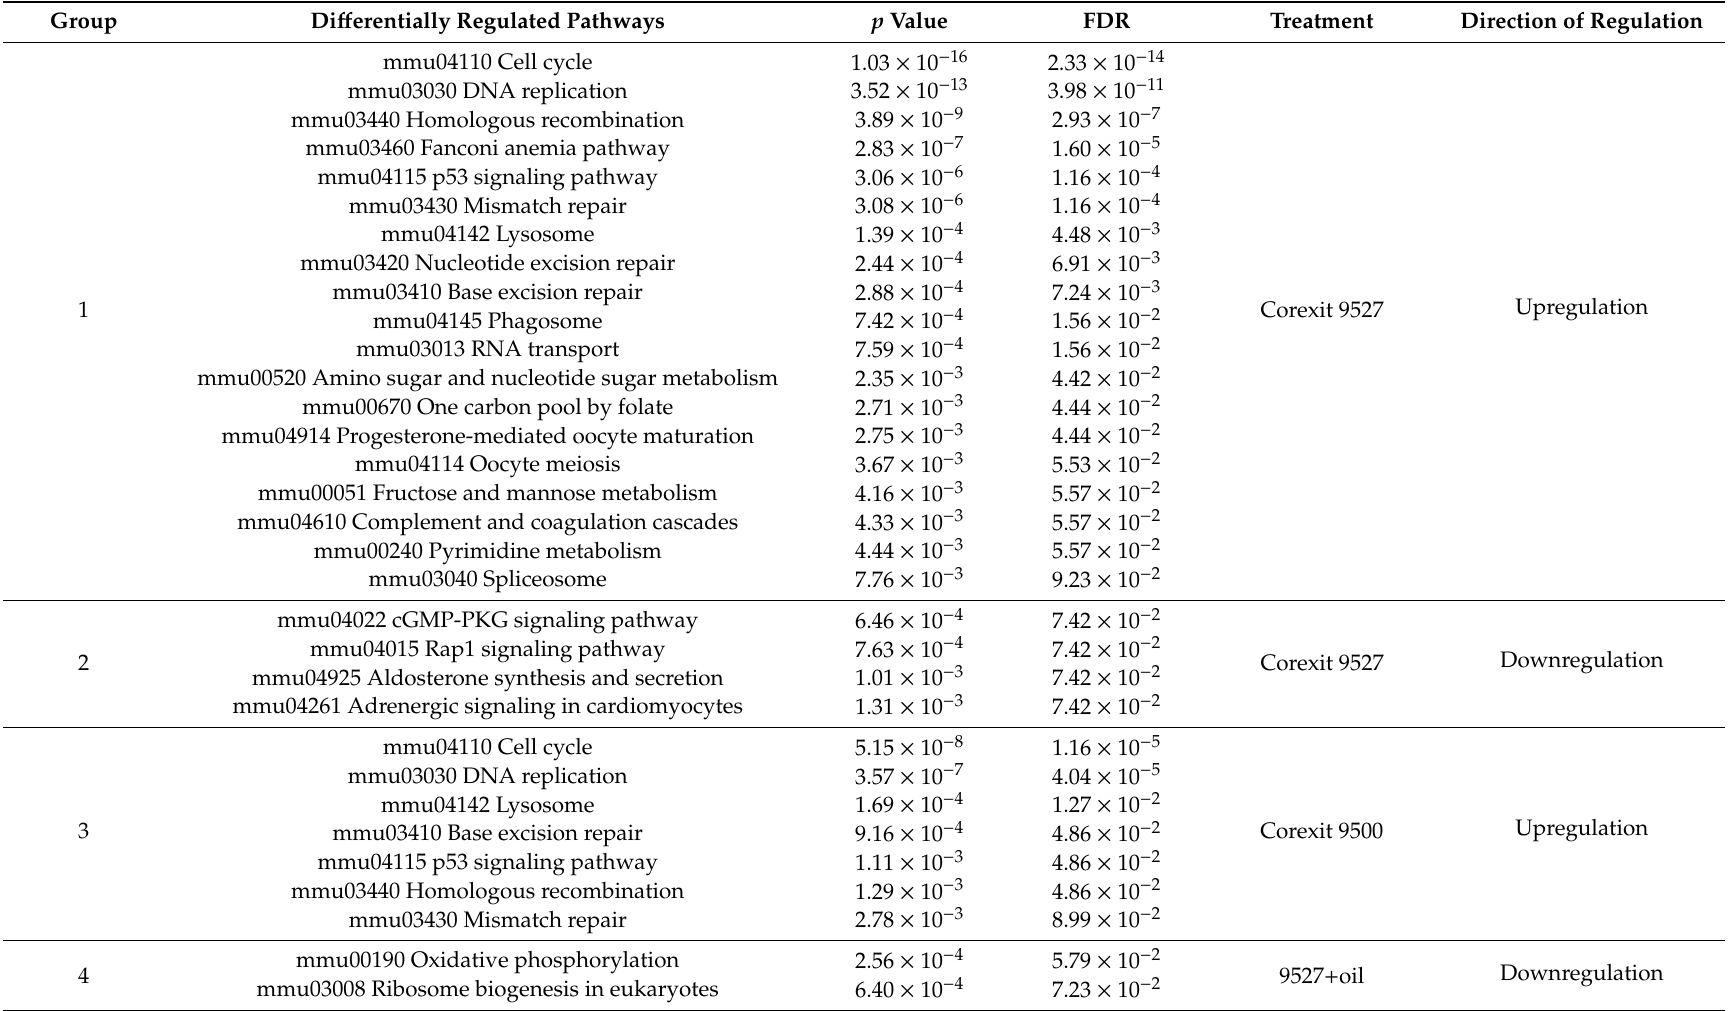
Table 1. Significantly regulated pathways by di ff erent